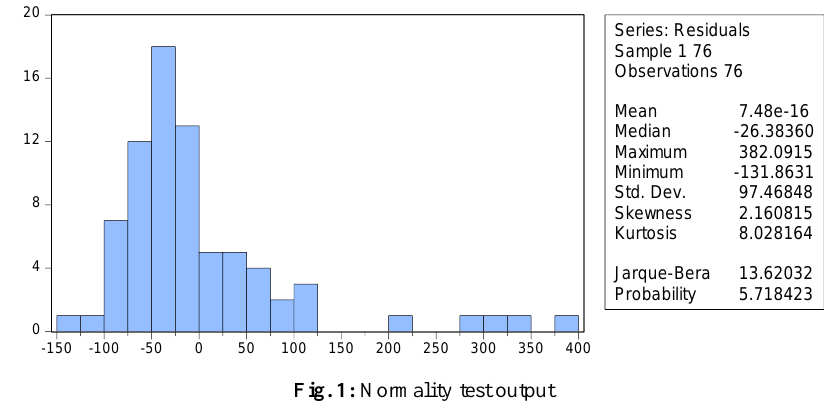
Fig. 1: Normality test output